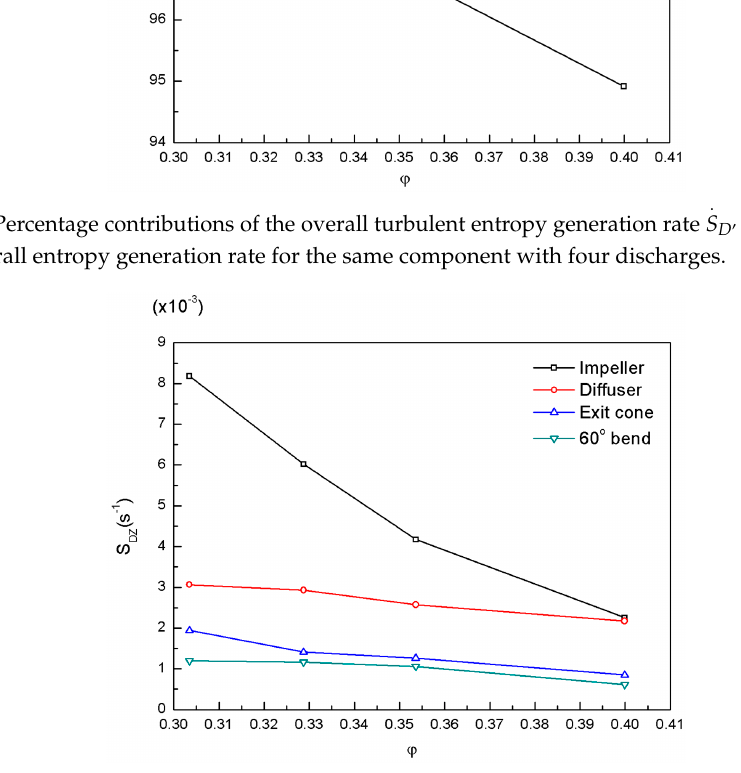
Figure 9. The 𝑆 (cid:3005)(cid:3027) (reflecting the overall turbulent entropy generation rate for a domain) of different Figure 9. The S DZ (reflecting the overall turbulent entropy generation rate for a domain) of di ff erent components for four discharges components for four